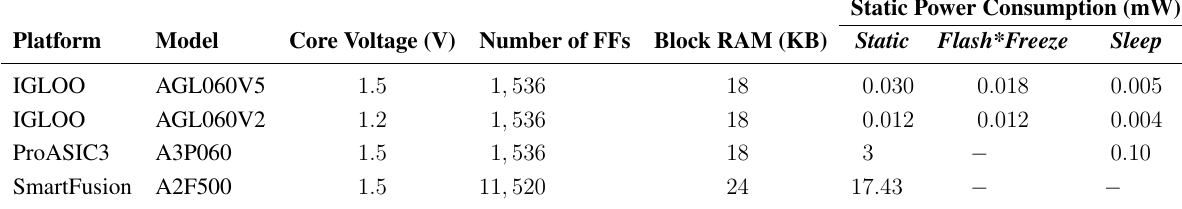
Table 3. Power consumption and operating voltage of Actel